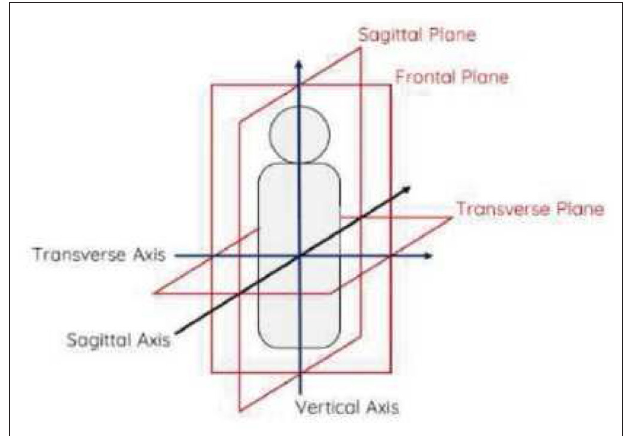
FIGURE 1 | Body planes (sagittal, frontal, and transverse) and axes (sagittal, vertical, and transverse) 3